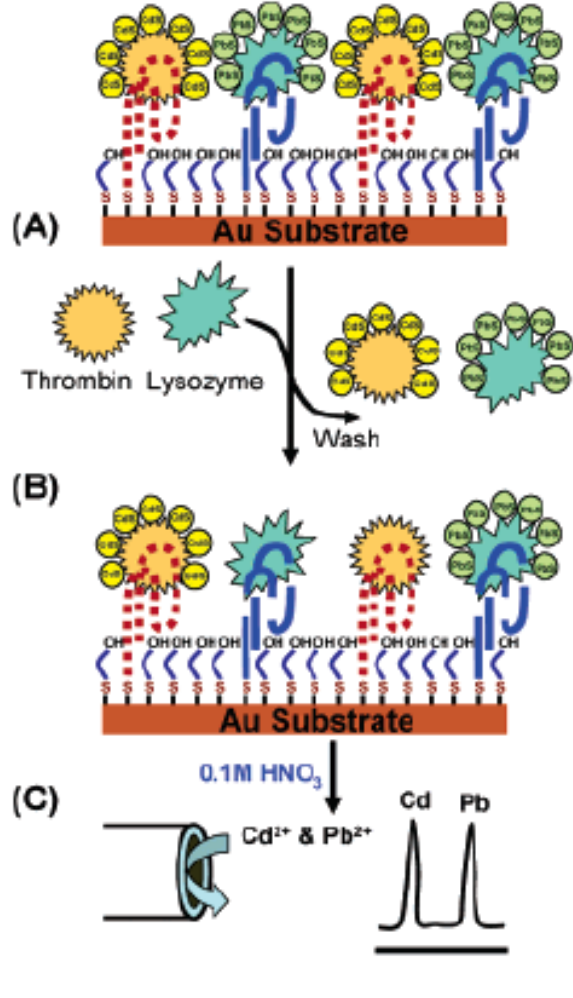
Figure 4. Operation of the aptamer/QD-based dual-analyte biosensor, involving displacement of the tagged proteins by the target analytes. (A) Mixed monolayer of thiolated aptamers on the gold substrate with the bound protein-QD conjugates; (B) sample addition and displacement of the tagged proteins; (C) dissolution of the remaining captured nanocrystals followed by their electrochemical-stripping detection at a coated glassy carbon electrode. Reproduced from